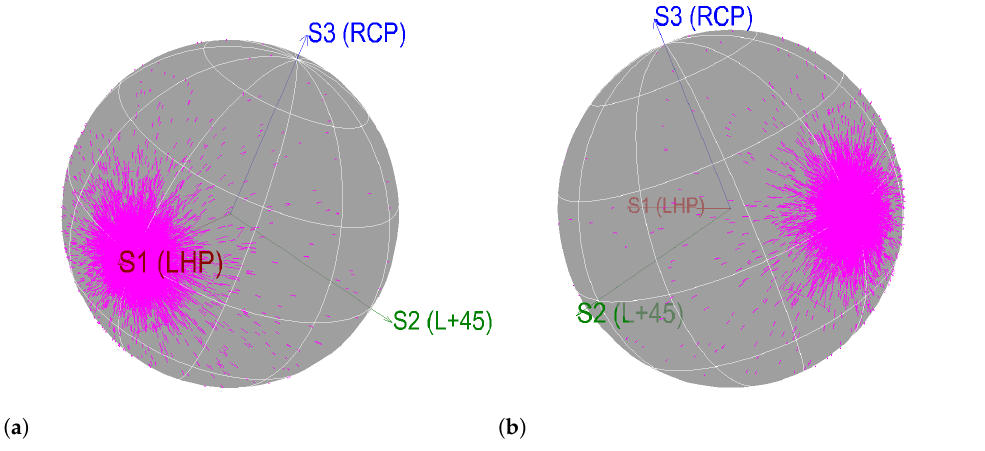
Figure 15. Poincare spheres of the multiplexed signals from OLT1 ( a ) and OLT2 ( b ).